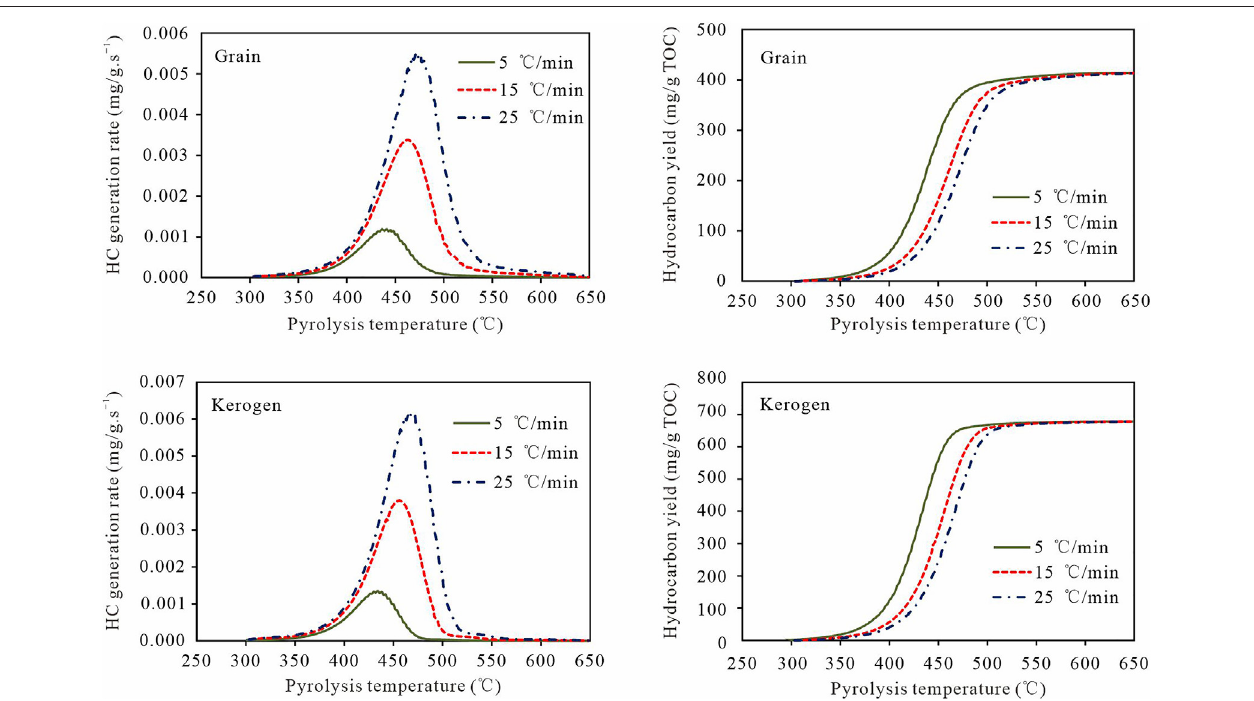
FIGURE 2 | Hydrocarbon (HC)-generating rates and hydrocarbon yield of grain and kerogen from NJZ shale as a function of pyrolysis temperature at different heating rates.